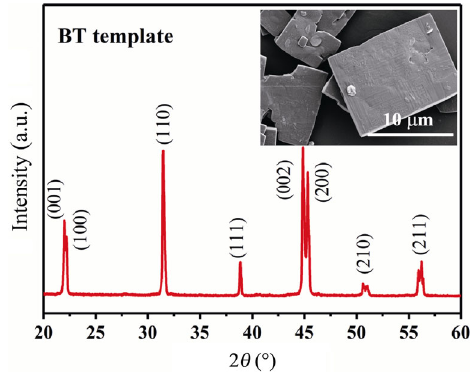
Fig. 2 XRD pattern of the BT template particles (inset is the corresponding SEM image).